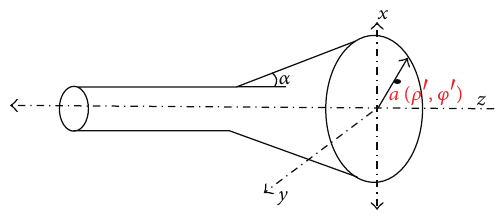
Figure 2: Conical horn